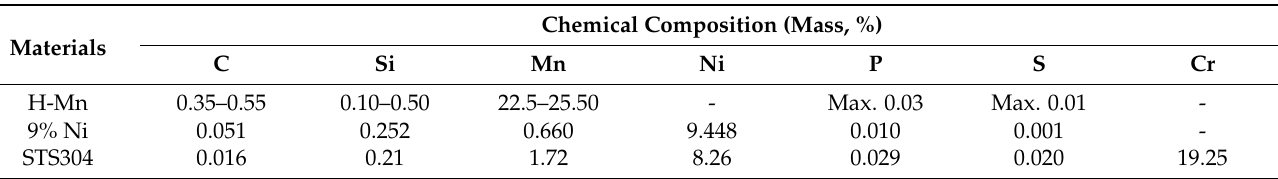
Table 1. Chemical compositions of the cryogenic